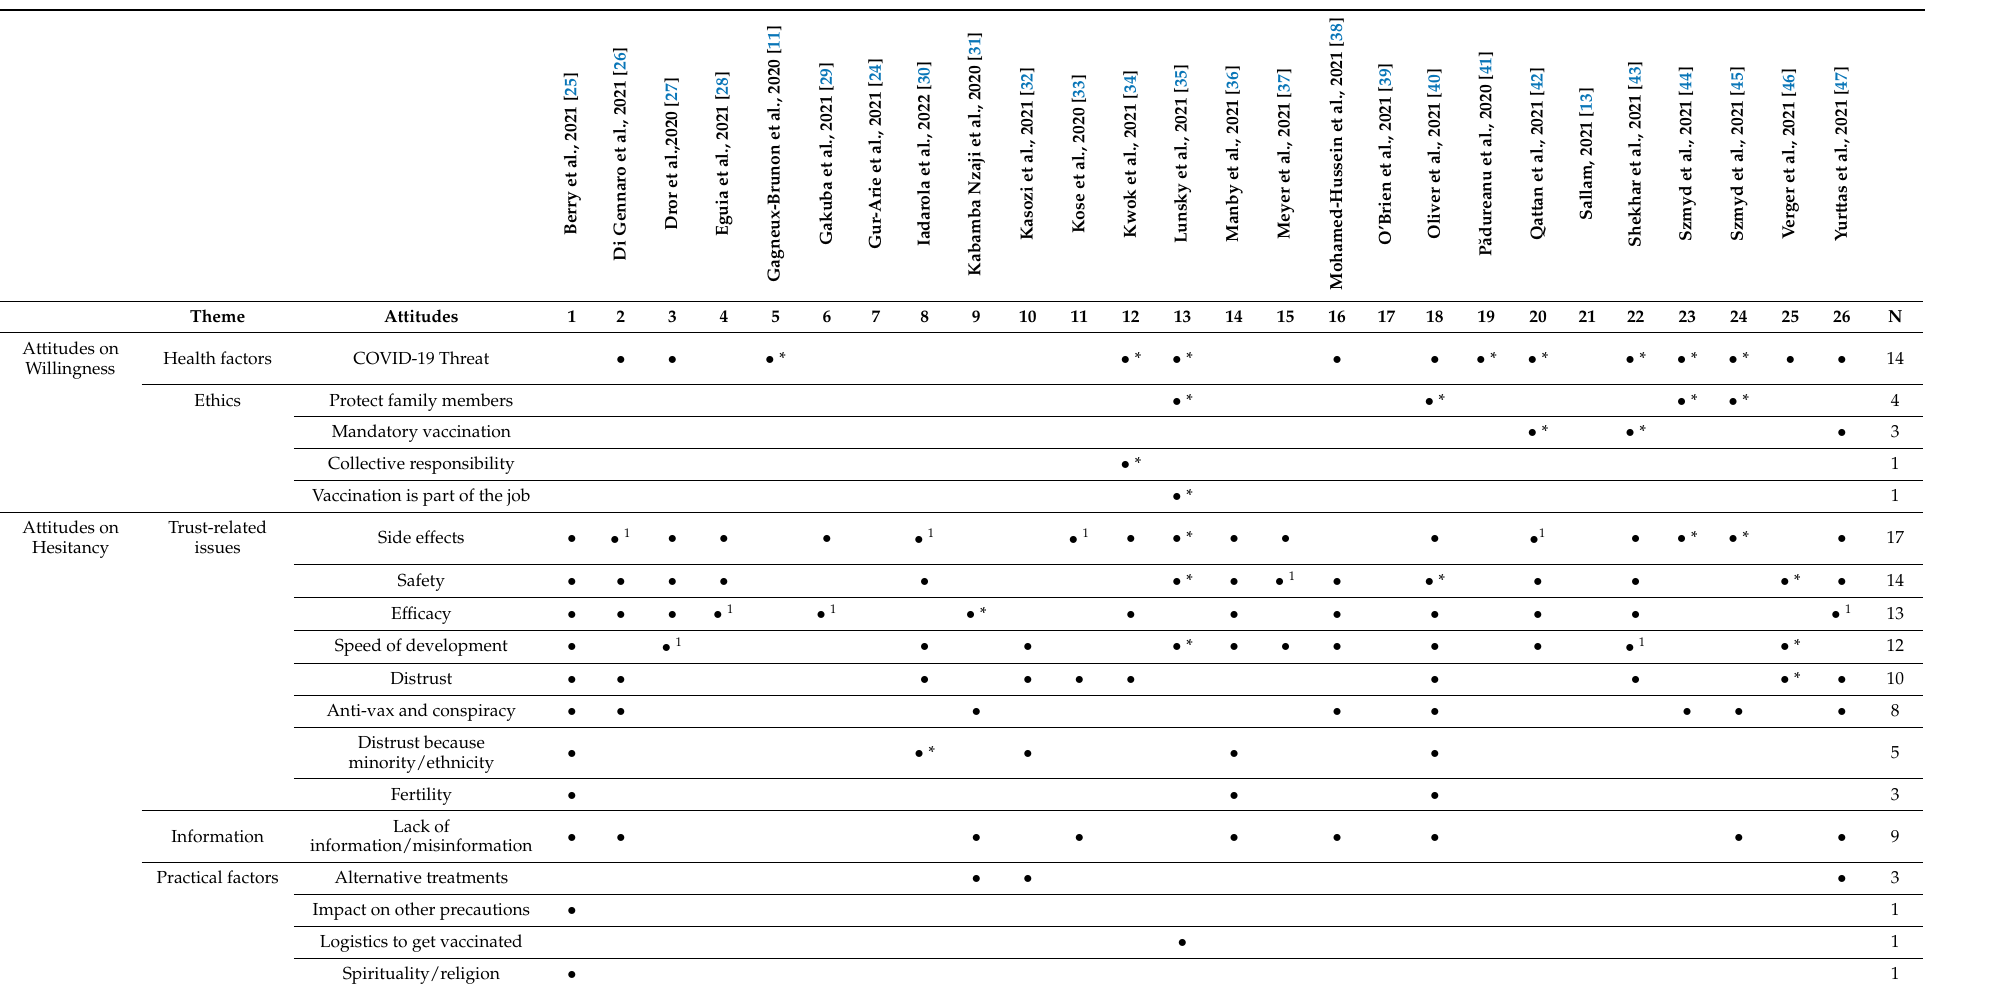
Table 3. Attitudes toward vaccine willingness and vaccine